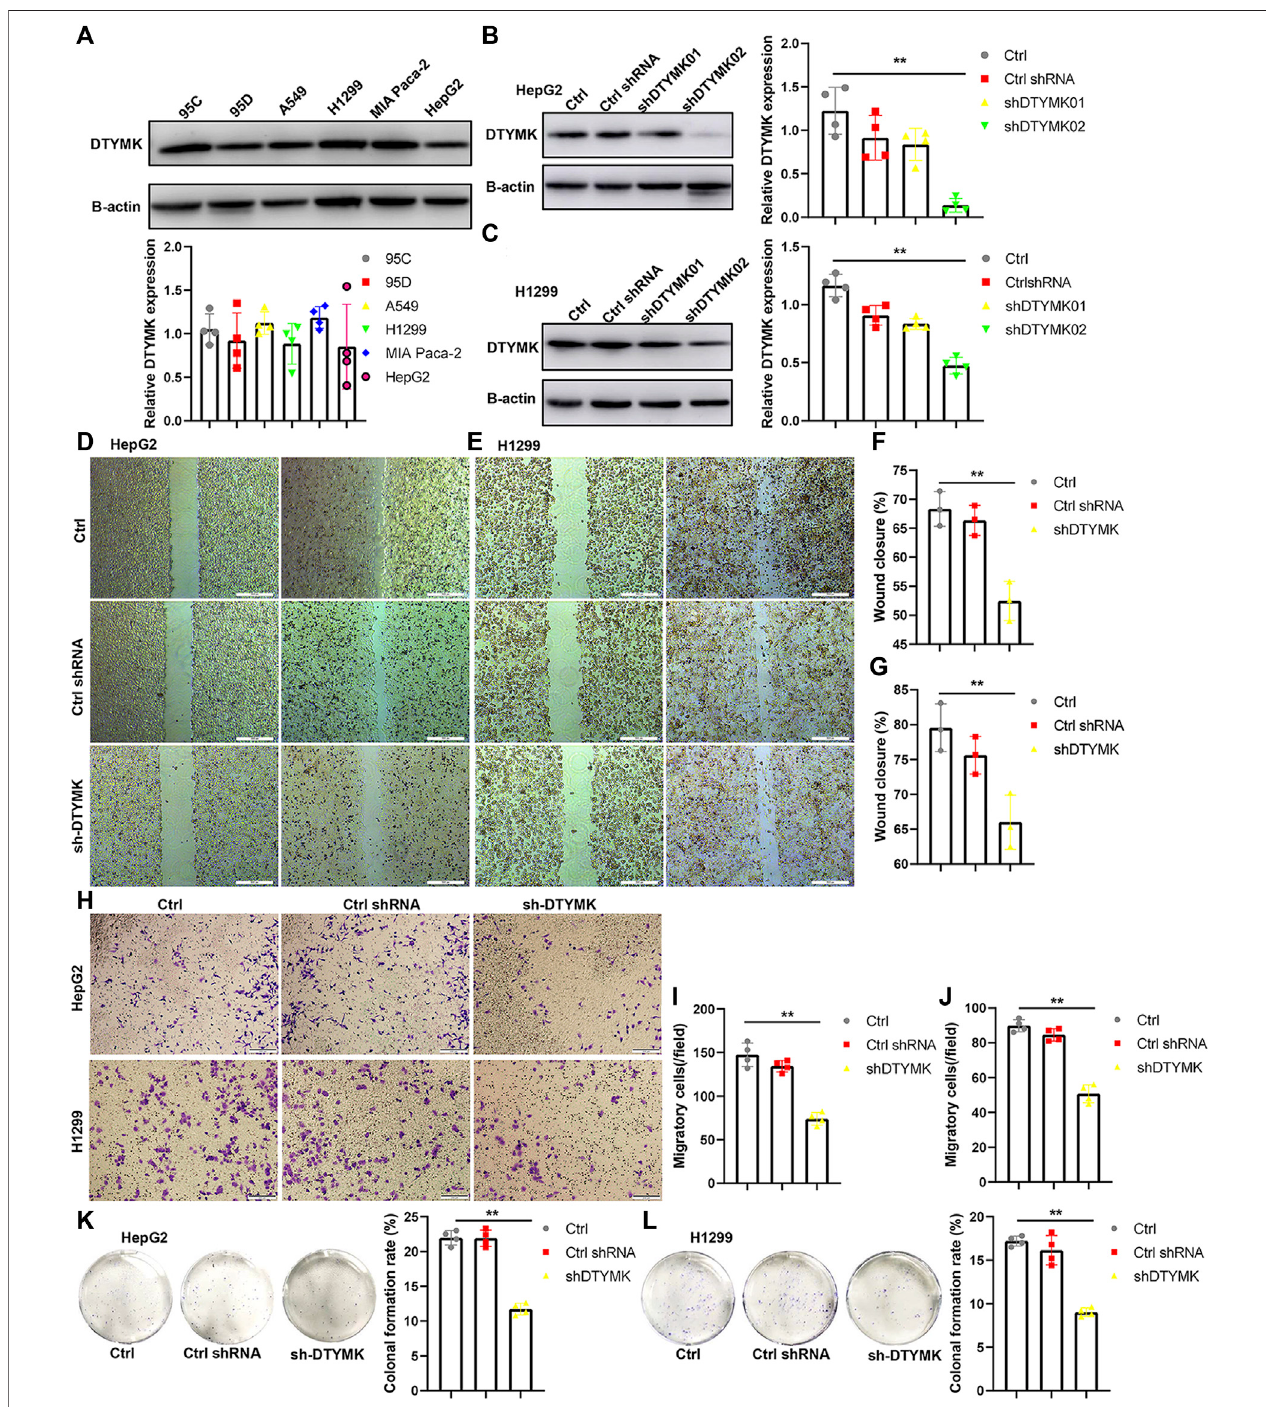
FIGURE 14 | Knockdown of DTYMK expression suppressed cell migration and colony formation. (A) DTYMK protein expression in multiple tumor cell lines, including95C,95D,A549,H1299,MIAPaca2,andHepG2. (B)(C) shDTYMK02ratherthanshDTYMK01knockeddownDTYMKexpressioninHepG2andH1299cells. (D – G) Knockdown of DTYMK expression dampened cell migration of HepG2 and H1299 cells detected by wound healing assay. (H – J) Knockdown of DTYMK expression dampened cell migration of HepG2 and H1299 cells detected by Transwell assay. (K – L) Knockdown of DTYMK expression inhibited plate colony formation of HepG2 and H1299 cells. ** p <